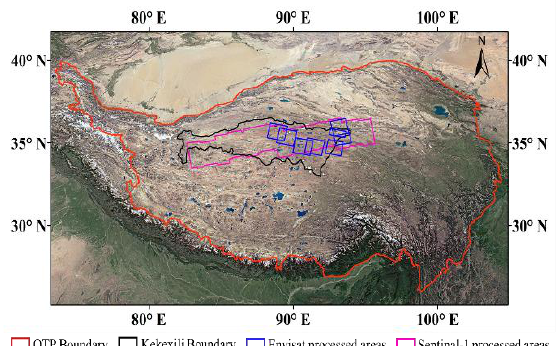
Figure 2. The areas processed by InSAR